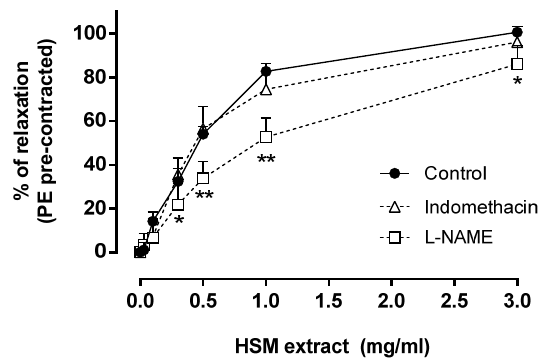
Figure 2. The relaxant effects of increasing concentrations of H. stoechas (HSM) extract in the absence (control) and presence of L-NAME (10 μ M) or indomethacin (10 μ M) on PE-induced contractions evoked in isolated rat aorta rings. Data points are mean ± SEM ( n = 6–8). * p < 0.05 and ** p < 0.01 vs. control.